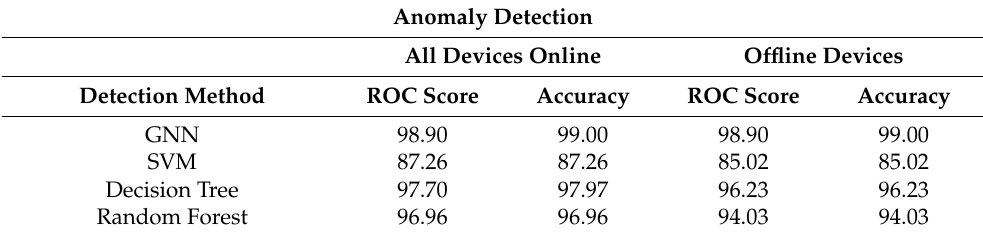
Table 2. DoS attack evaluation results.